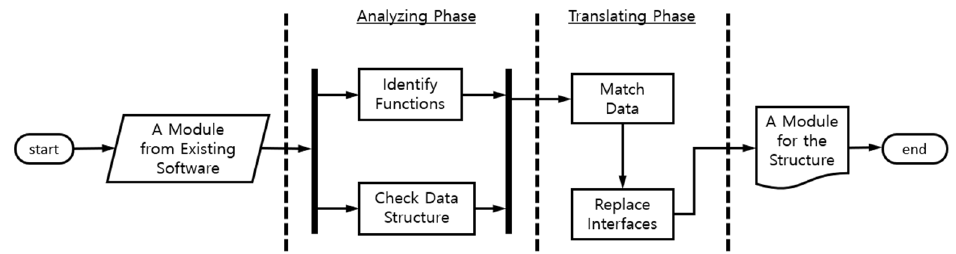
Figure 14. The flow of the Interface and Data Translator.